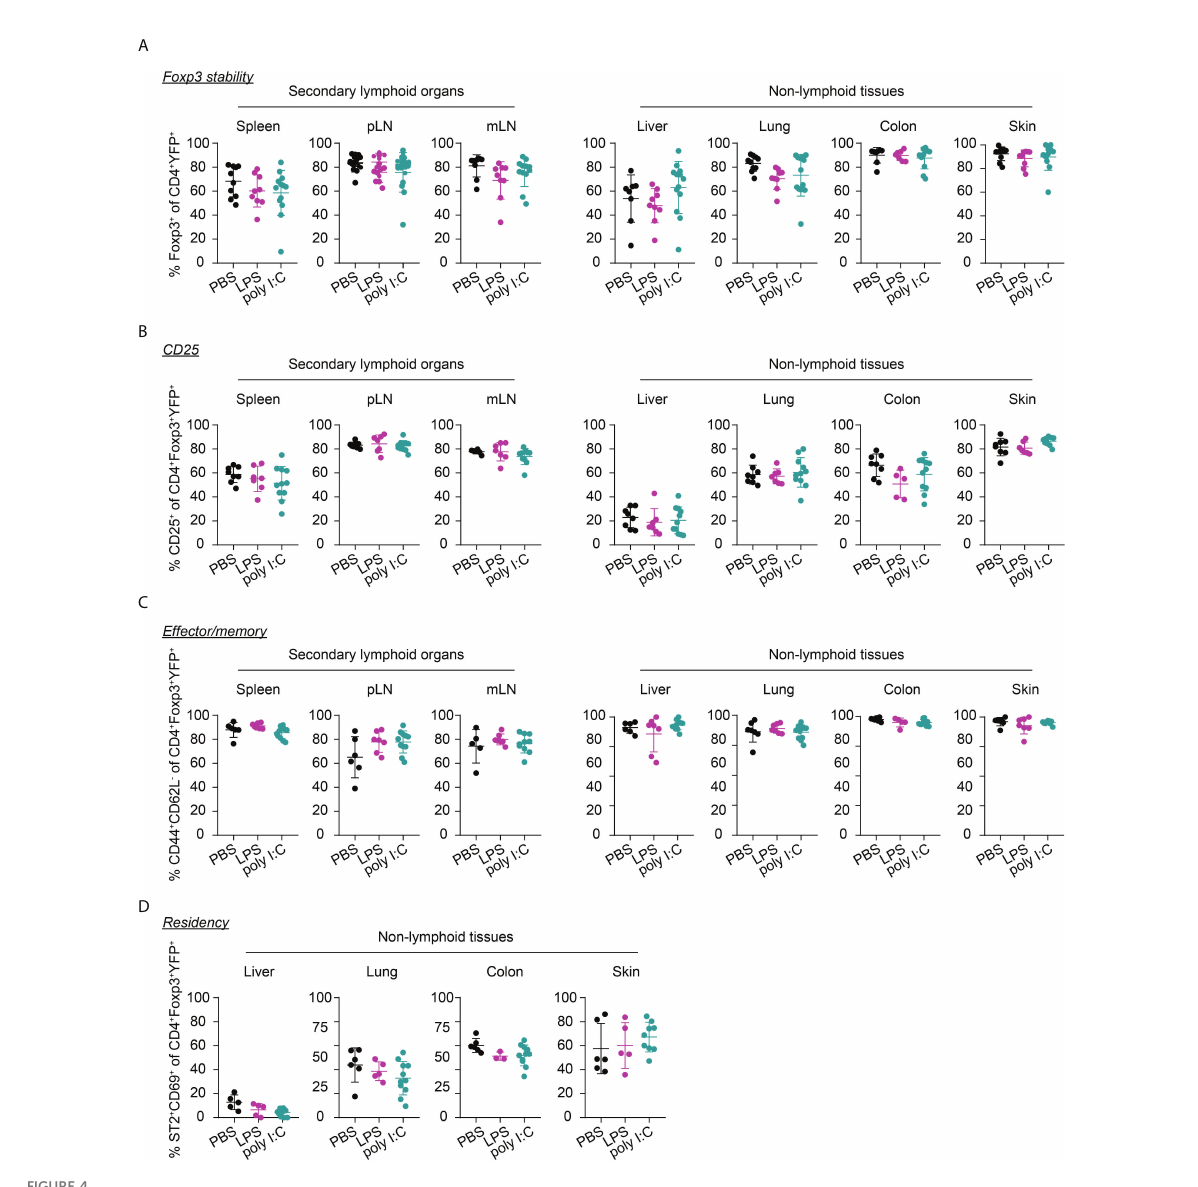
FIGURE 4 Immunophenotype of neonatally-tagged Tregs 12 weeks post neonatal in fl ammatory perturbation. Newborn Foxp3 eGFPCreERT2 xROSA26 STOP-eYFP mice were intraperitoneally injected with LPS, poly I:C or PBS as control, received repetitive intragastric injections of tamoxifen at days 2, 5 and 8 after birth, and were sacri fi ced at indicated time points after challenge. Scatter dot plots depict frequencies of Foxp3 + cells among CD4 + YFP + T cells (A) , and of CD25 + cells (B) , CD44 + CD62L - cells (C) , and ST2 + CD69 + cells (D) among neonatally-tagged YFP + Foxp3 + Tregs across indicated organs. Data in scatter dot plots are depicted as mean ± SD, each dot represents a single mouse, and data were pooled from 4 to 6 independent experiments (n =